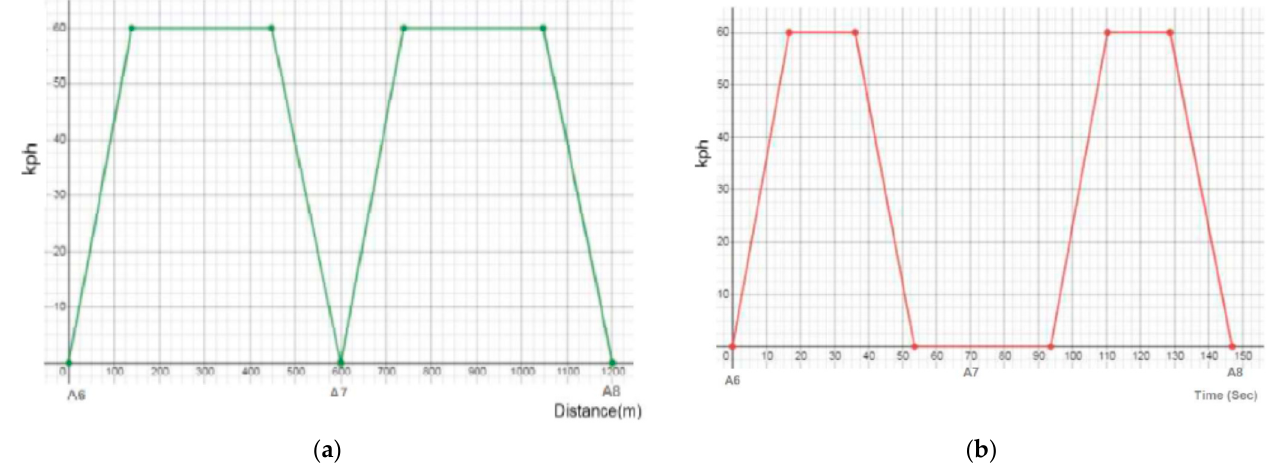
Figure 3. A schematic diagram represents the train movement from A6 to A8. ( a ) Distance. ( b ) Time.